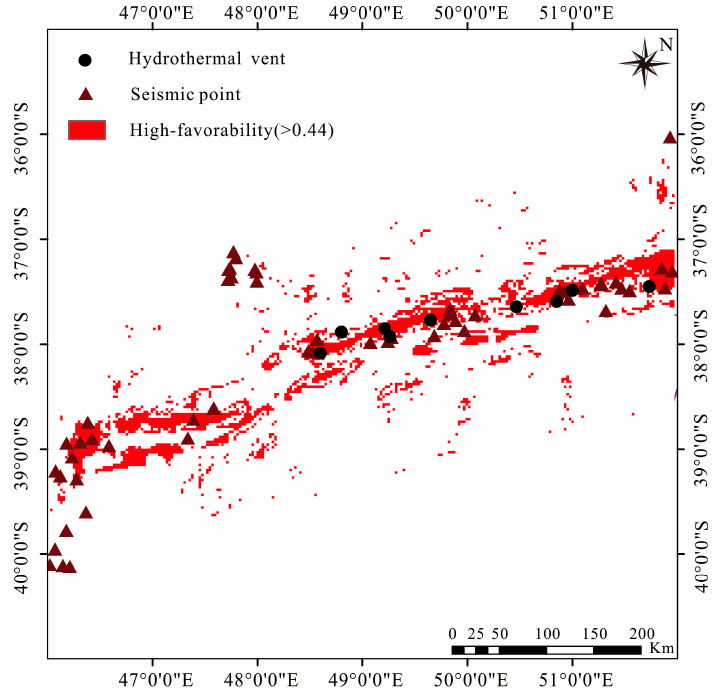
Figure 8. Mineral prospective map based on fuzzy analytical hierarchy process.